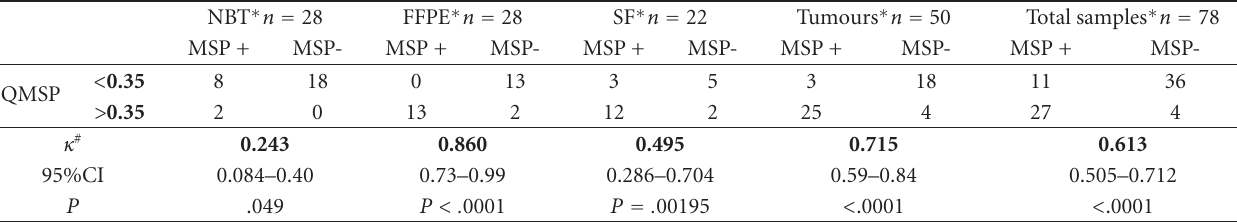
Table 3: Comparison of MGMT methylation status as determined by Quantitative Methylation-Specific PCR (QMSP) and. Methylation- Specific PCR (MSP).